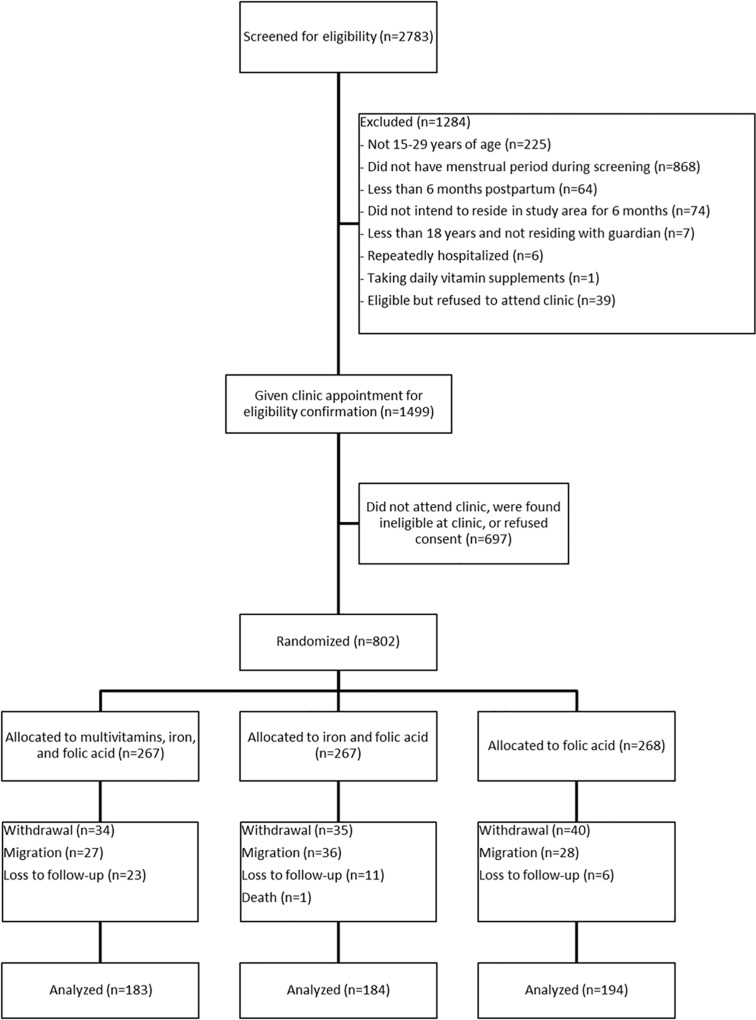
Flow of study participants.